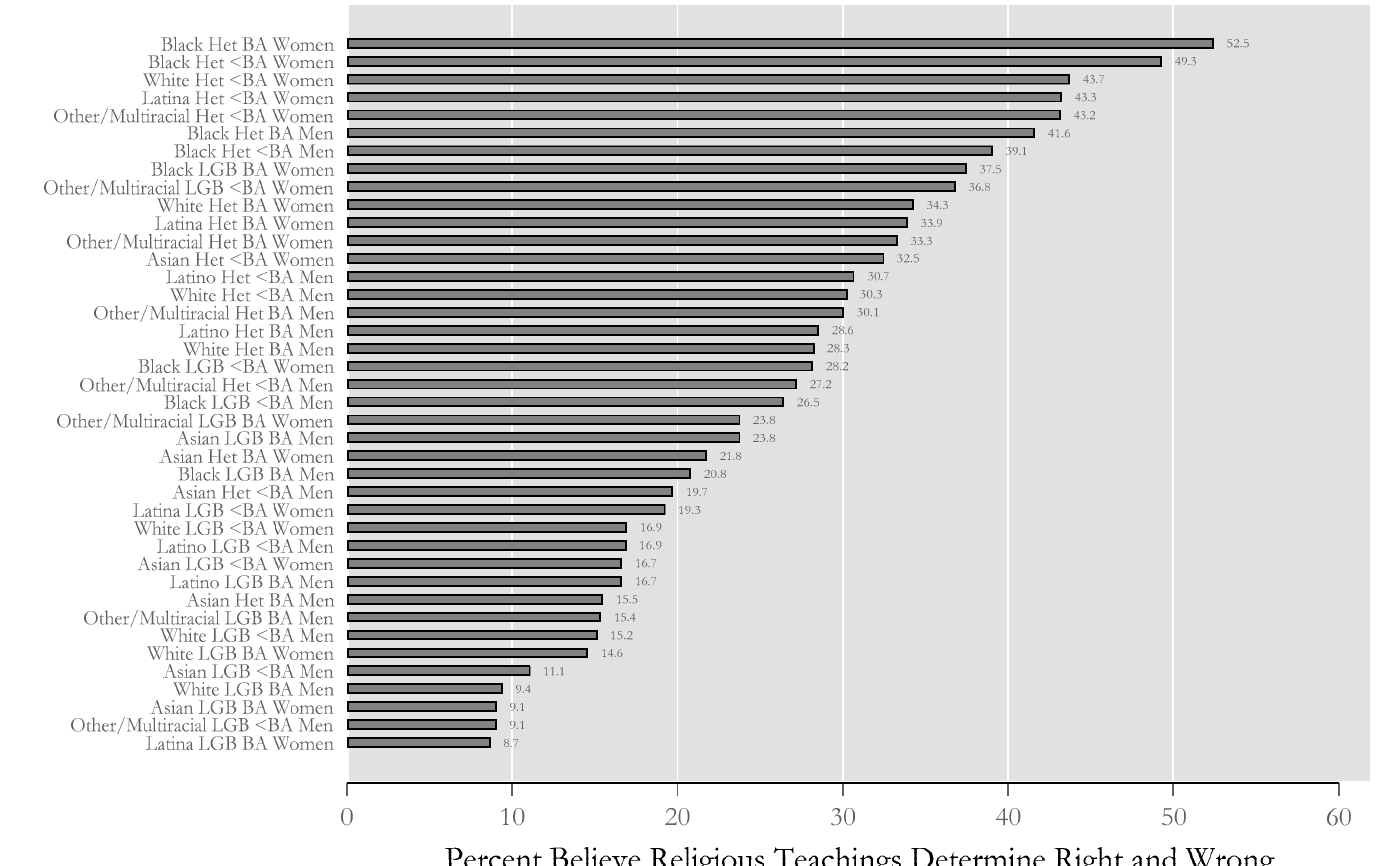
Figure A3. Religious teachings and beliefs more important than philosophy and reason, practical experience and common sense, and scientific information in determining right and wrong, RLS (N = 32,578).